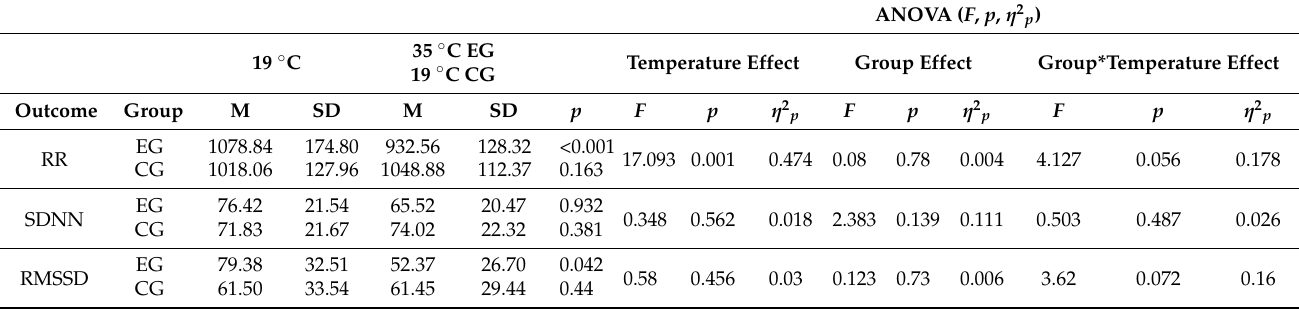
Table 3. Differences on heart rate variability depending on ambient temperature in experimental an control groups during last 5 minutes of